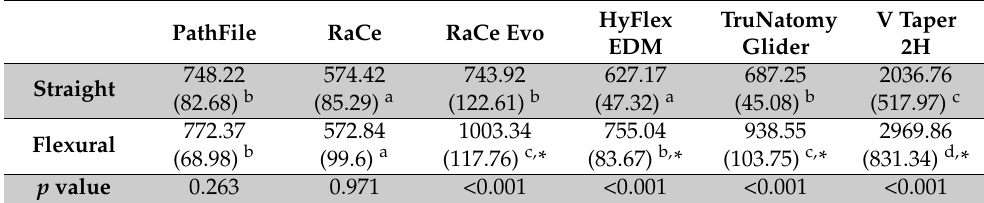
Table 3. Instrument’s distortion angle (degrees) from torsional fracture resistance testing in straight and flexural mode shown as mean (standard